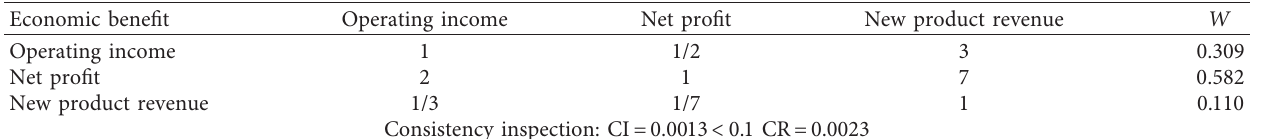
Table 7: Judgment matrix of economic